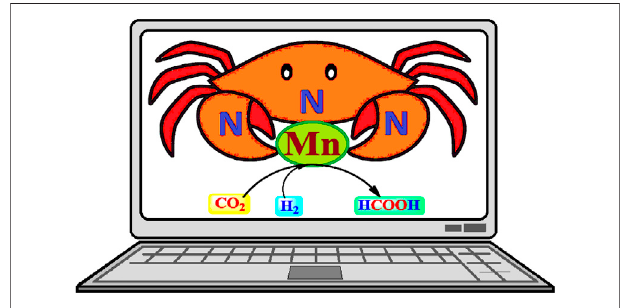
GRAPHICAL ABSTRACT | TOC for